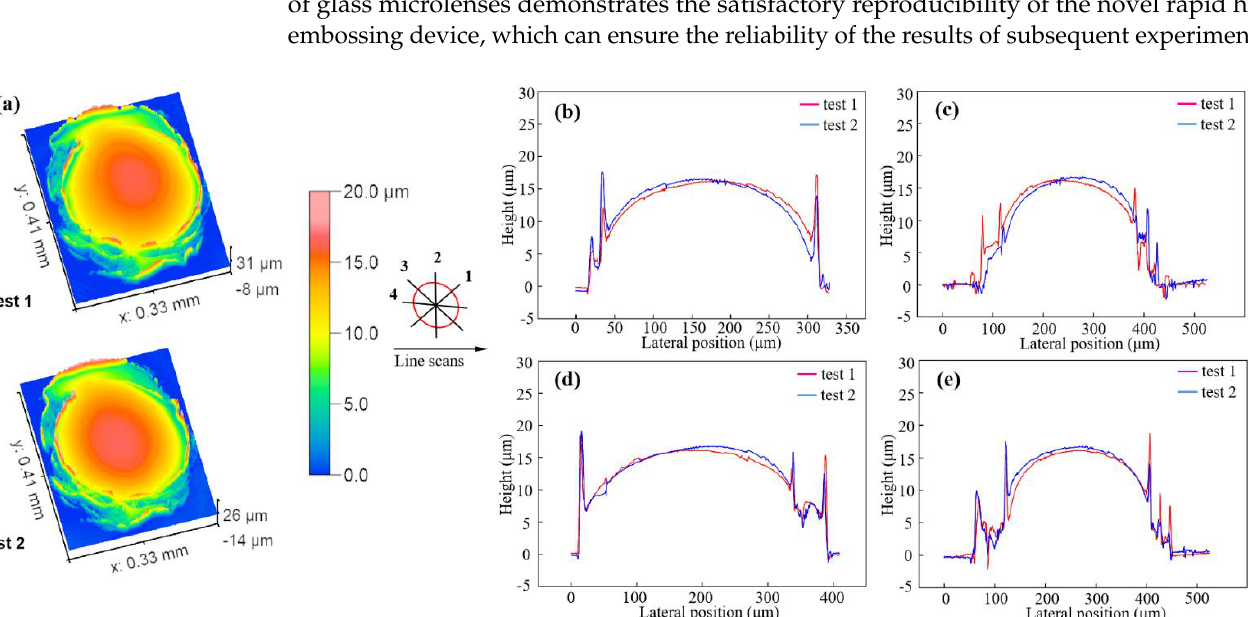
Figure 7. ( a ) Profiles, ( b ) maximum heights, and ( c ) curvature radii of microlenses under various embossing forces.